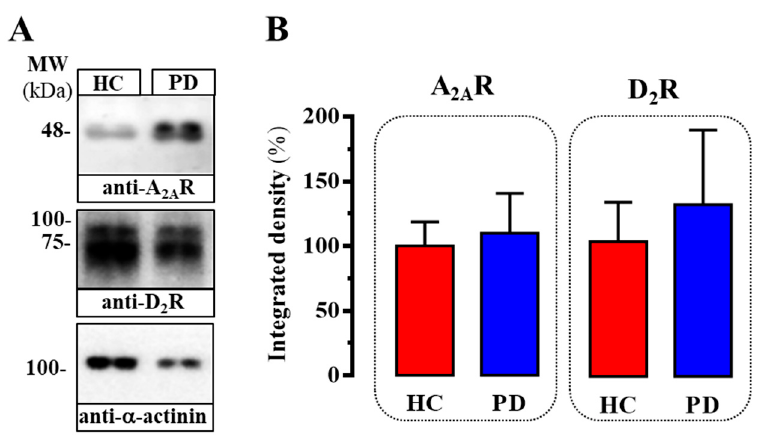
Figure 3. Expression of A 2A R and D 2 R in caudate from PD subjects. ( A ) Immunoblot showing the expression of A 2A R and D 2 R in caudate membranes from HC and PD subjects. Caudate membranes were analyzed by SDS-PAGE (60 μ g of protein/lane) and immunoblotted using goat anti-A 2A R, rabbit anti-D 2 R and rabbit anti- α -actinin antibodies (see Methods). ( B ) Relative quantification of A 2A R and D 2 R expression. The immunoblot protein bands corresponding to A 2A R, D 2 R and α -actinin